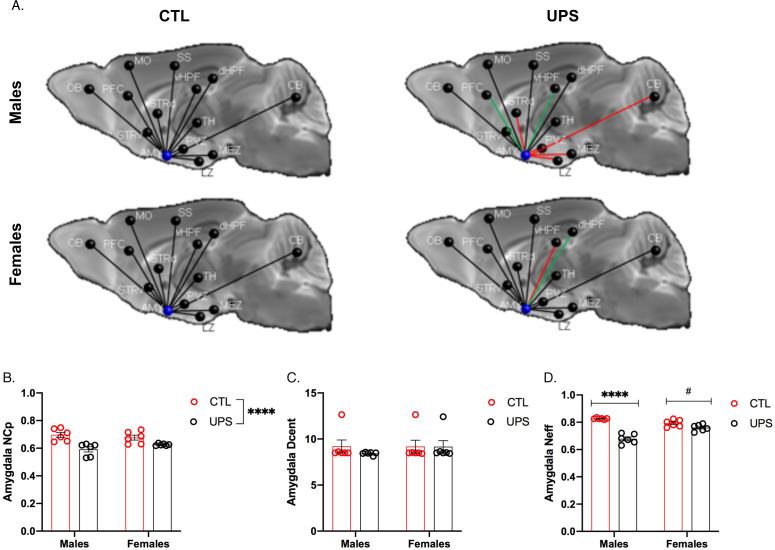
Effects of unpredictable postnatal stress and sex on AMY regional connectivity.(A) Schematic representation of AMY connectivity with other brain regions. Red lines indicate reduced connectivity and green lines indicate enhanced connectivity compared to same sex group. (B) Quantification for nodal clustering coefficient (NCp), (C) degree of centrality (Dcent), and (D) nodal efficiency (Neff). Abbreviations: amygdala (AMY), cerebellum (CB), dorsal hippocampus (dHP), dorsal striatum (STRd), lateral hypothalamic zone (LZ), medial hypothalamic zone (MEZ), motor cortex (MO), olfactory bulb (OB), periventricular zone (PVZ), prefrontal cortex (PFC), somatosensory cortex (SS), thalamus (TH), ventral hippocampus (vHP), ventral striatum (STRv). Mean and SEM, *p<0.05.Figure 9—source data 1.GRETNA codes used to assess amygdala connectivity.